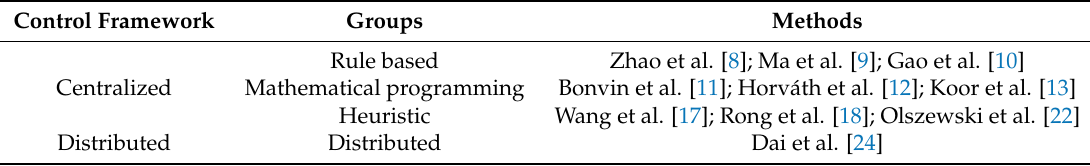
Table 1. Optimization methods for the system with parallel-connected